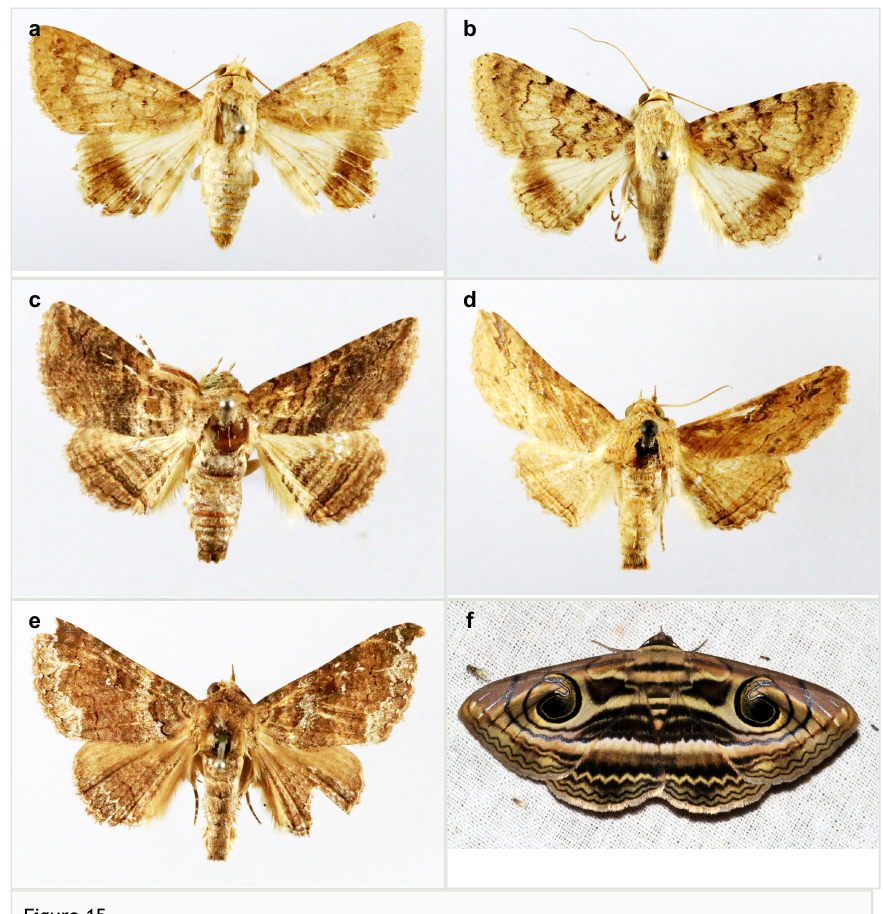
Figure 15. Adults of a. Pandesma anysa ; b. Pandesma quenavadi ; c. Pericyma albidens ; d. Pericyma glaucinans ; e. Pericyma umbrina ; f. Spirama